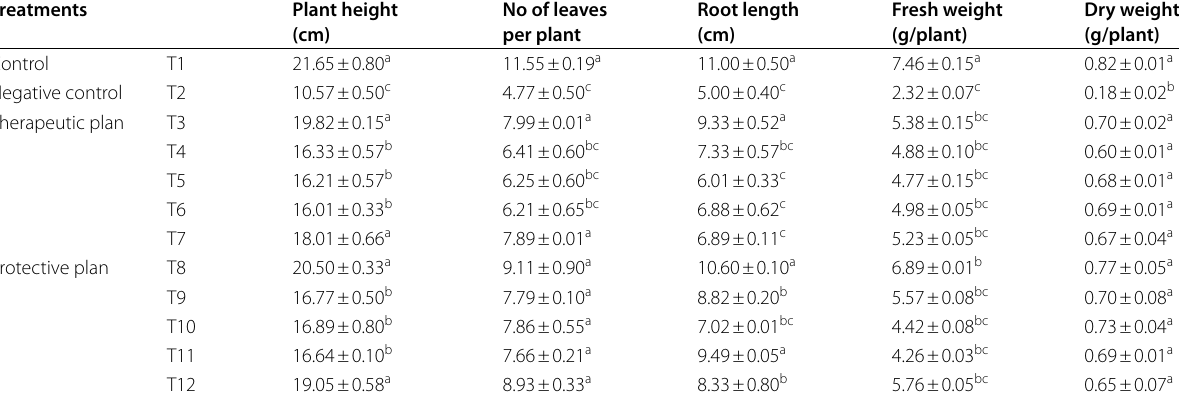
Calculated mean is for triplicate measurements from two independent experiments ± SD, a − c means with different superscripts in the same column for each nanoparticle are considered statistically different (LSD test, P ≤ 0.05) a rougher surface of the mycelia with shrinking (Fig. 3B and C). In addition, the mycelium was distorted with intense dehydration that resulted in completely damaged or dead cells.